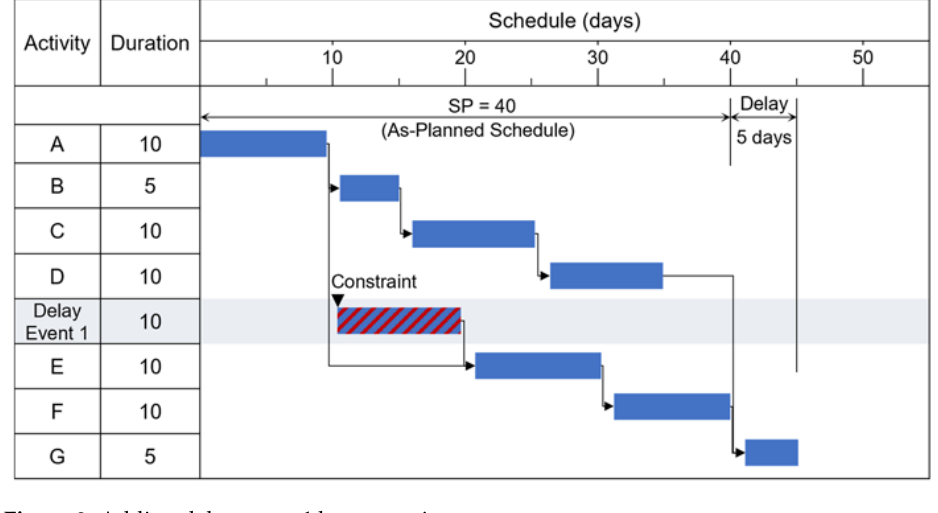
Figure 9. Adding delay event 1 by constraints.